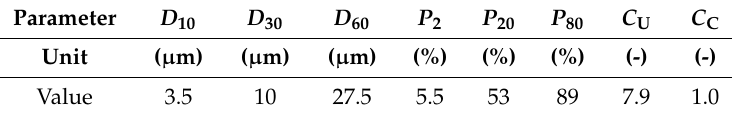
Table 1. Main grain-size distribution parameters for the Mine A tailings.